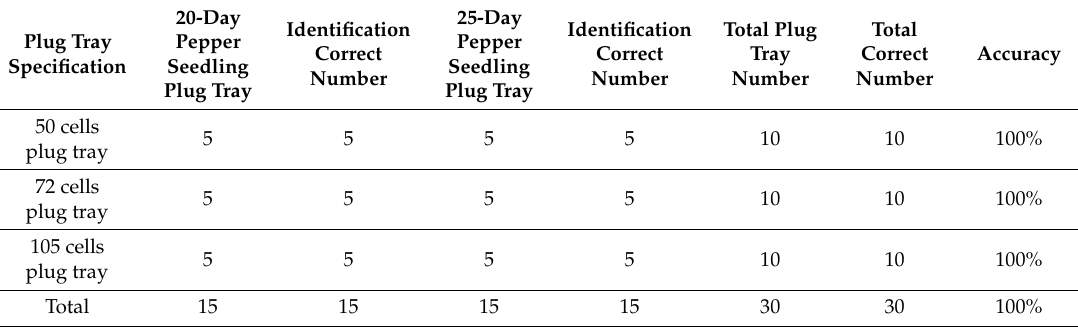
Table 3. Plug tray specification test result